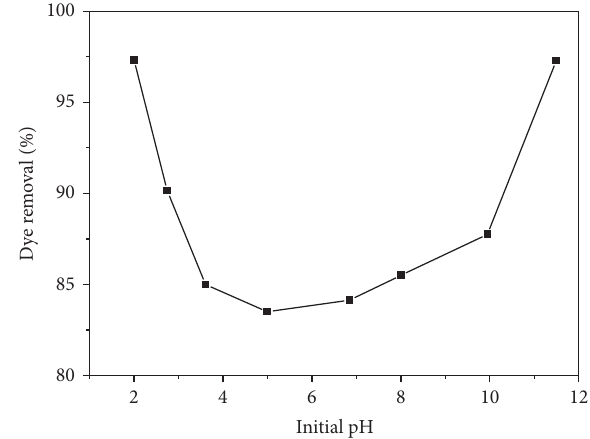
F 3: Effect of pH on MB adsorption (